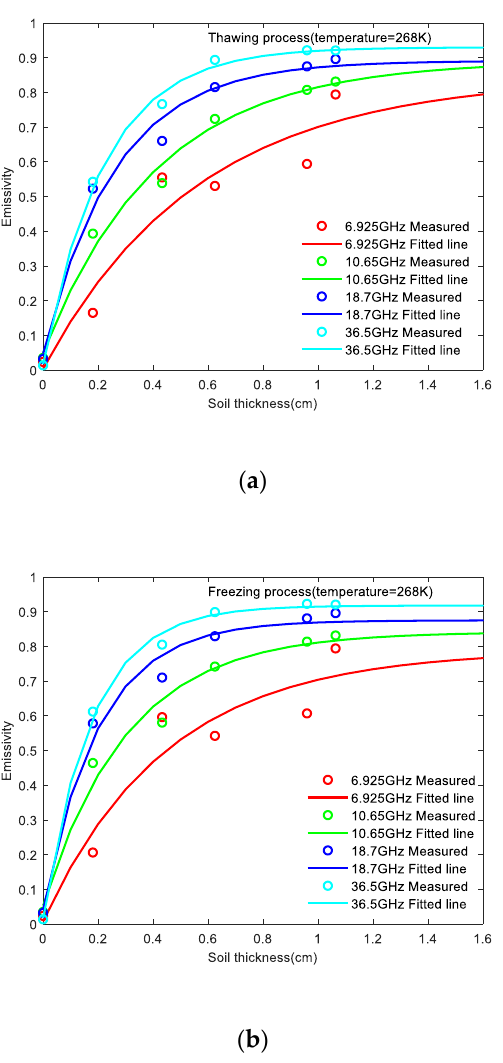
Figure 11. Measured and fitted relationships between soil thickness and emissivity at four frequencies during the thawing process ( a ) and freezing process ( b ).